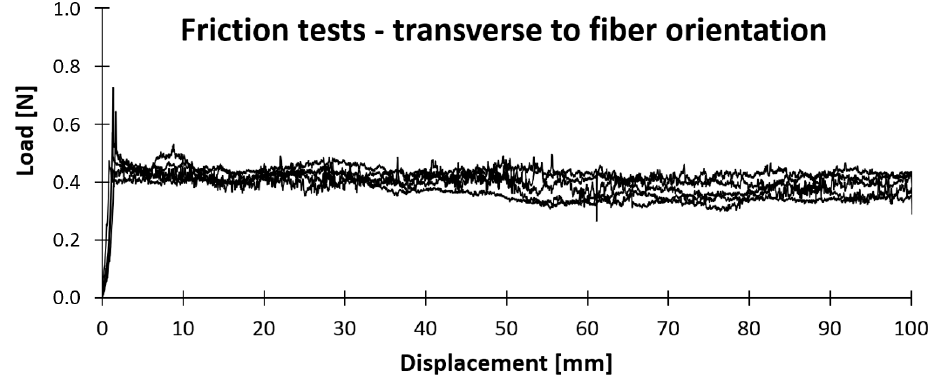
Figure 10. Experimental results of the friction tests on PP-GF plate specimens with transverse fiber orientation.